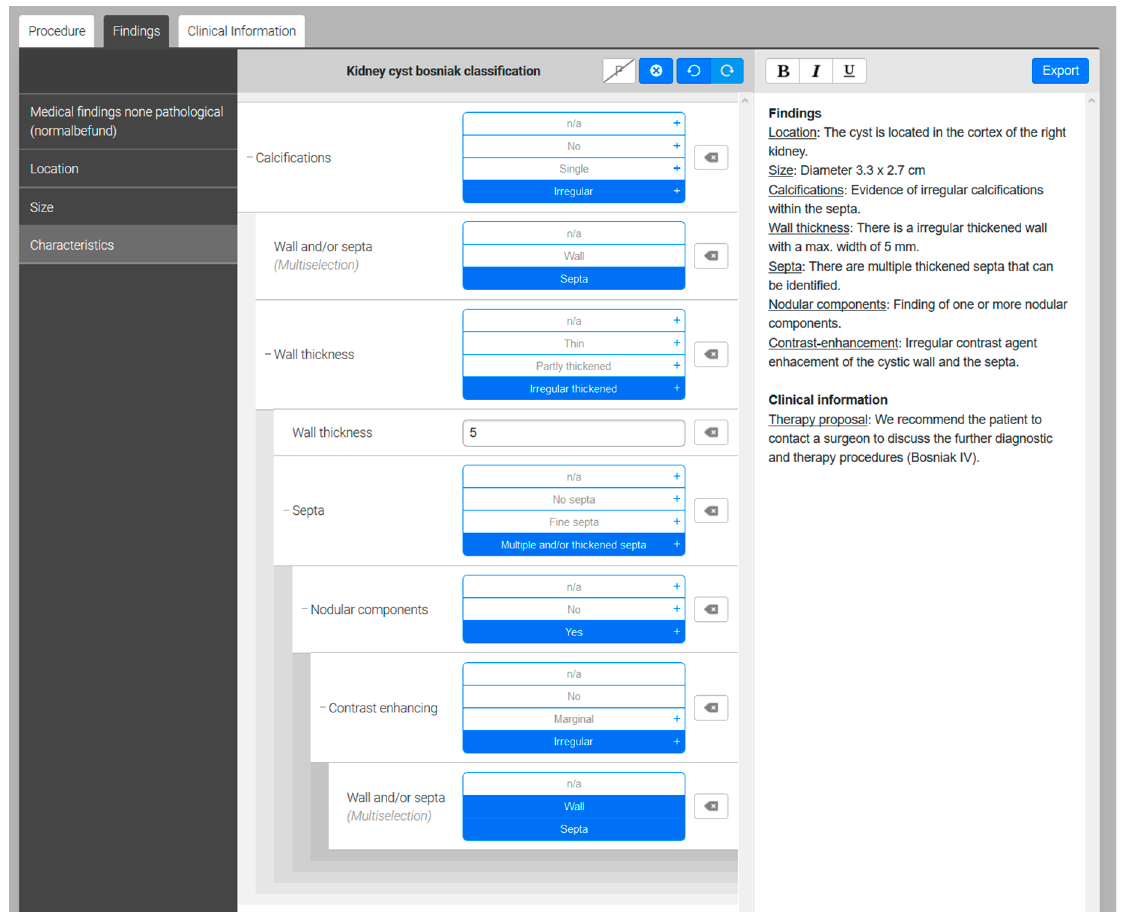
Figure 3. Screenshot of the clickable decision-tree provided by the structured reporting software. The template provides several clickable items and subitems on the left side. By clicking the appropriate items, semantic sentences including Bosniak classification and appropriate therapy proposals are generated by the software on the right side.